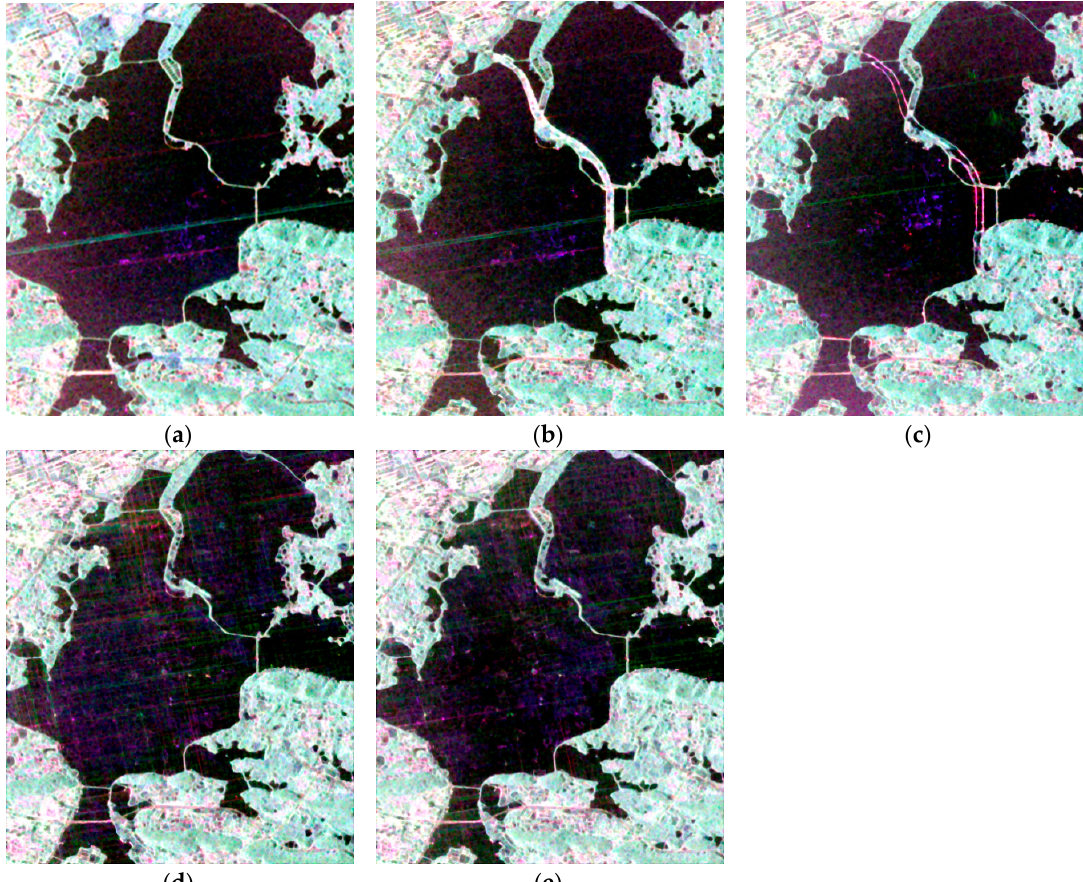
Figure 11. RADARSAT-2 PolSAR images acquired on ( a ) 7 December 2011. ( b ) 25 June 2015. ( c ) 6 July 2016; and GF-3 PolSAR images acquired on ( d ) 30 April 2017. ( e ) 29 May 2017.